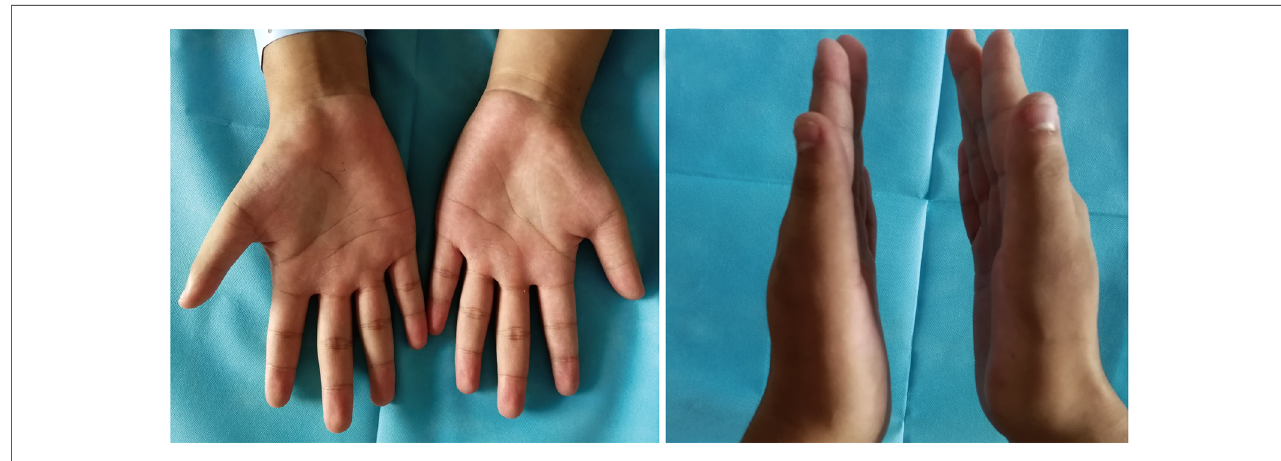
FIGURE 1 Preoperative physical examination. Bilateral thenar muscle atrophy, and the right thenar muscle was signi fi cantly atrophied compared to the contralateral